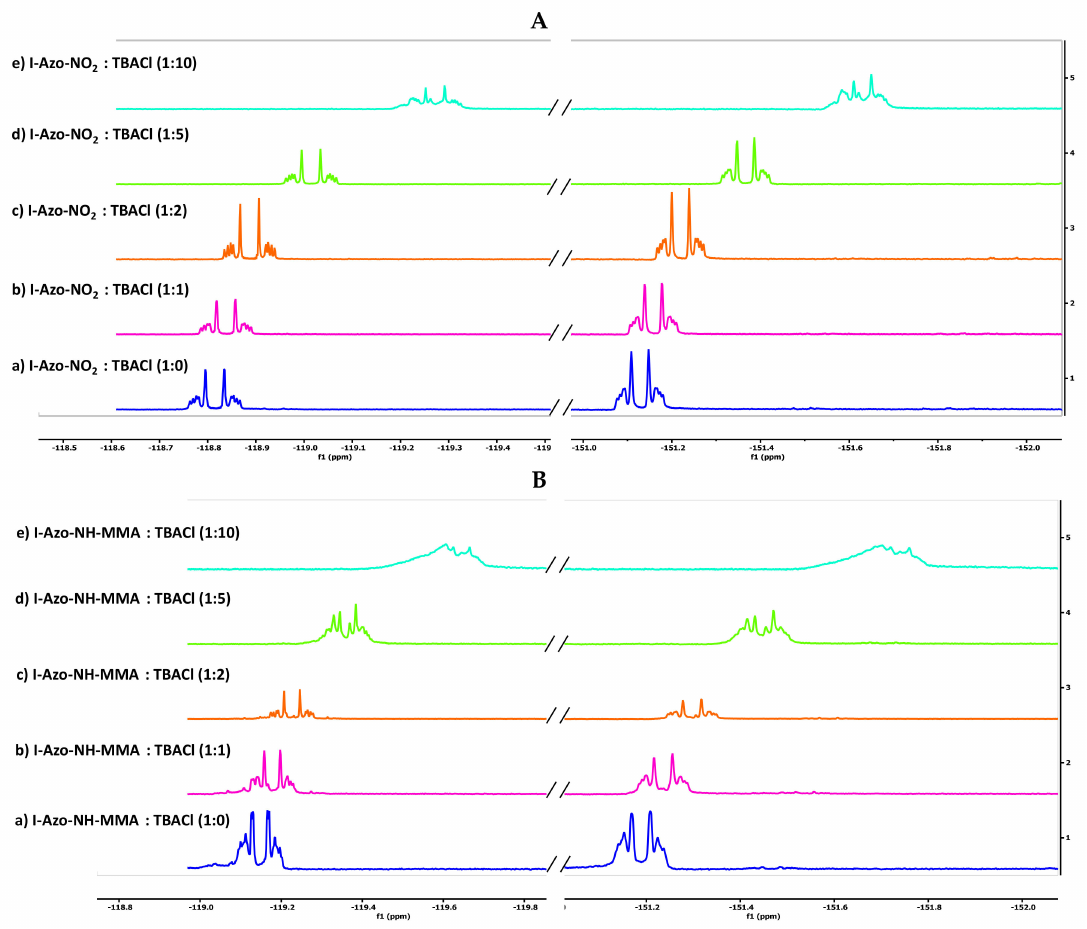
Figure 4. Stack plot of 19 F-NMR spectra of I–azo–NO2 and I–azo–NH–MMA (CDCl 3 ), at different molar ratios of I-azo- NO 2 /TBACl ( A ) and I–azo–NH–MMA/TBACl ( B ). Molar ratios: (a) 1:0; (b) 1:1; (c) 1:2; (d) 1:5; (e)